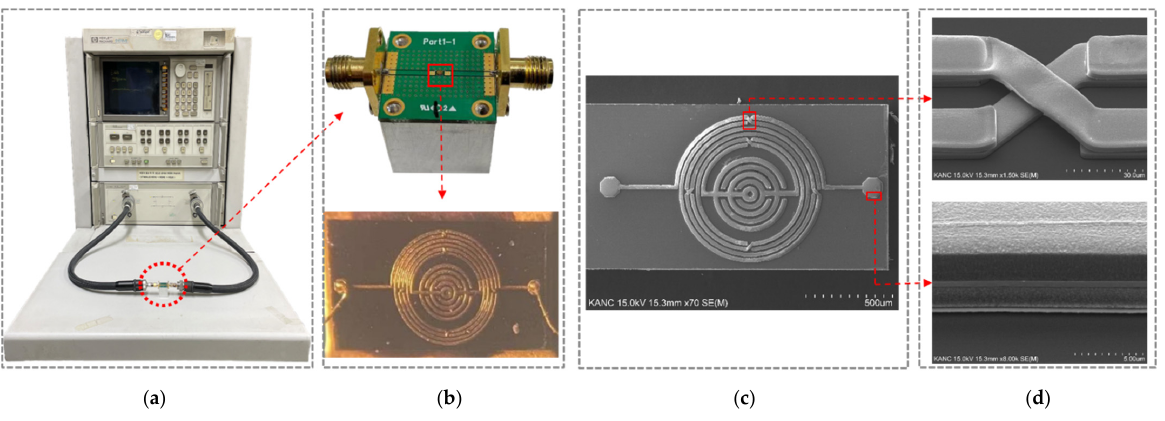
Figure 8. ( a ) Measurement setup (VNA); ( b ) BPF fixed on an aluminum cube and the top view of the fabricated product; ( c ) top view of the SEM image; ( d ) enlarged view of air-bridge structure and cross-section of the three metal layers.